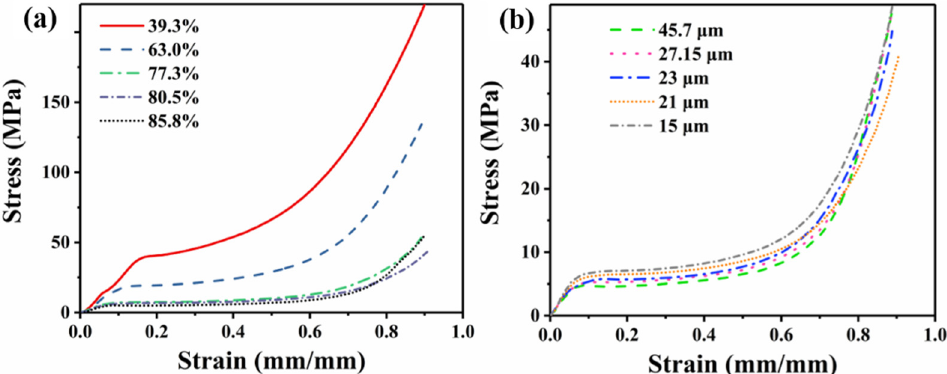
Figure 6. Stress–strain curves of the foamed sample as a function of its porosity and cell size: ( a ) cell size of nearly 20 µ m and ( b ) porosity of nearly 82%.